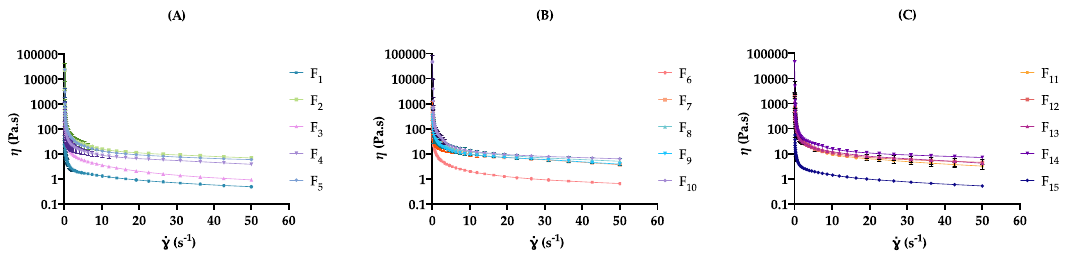
ff ect of independent variables on cream viscosity: ( A ) F Figure 2. Effect of independent variables on cream viscosity: (A) F 1 -F 5 , (B), F 6 -F 10 and (C) F 11 -F 15 . Figure 2. E